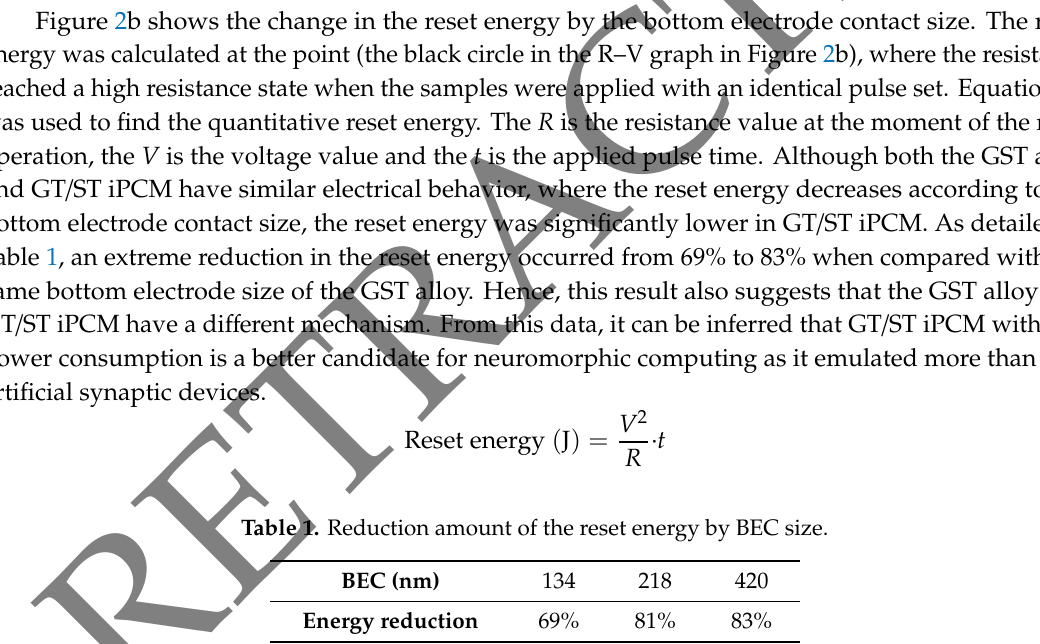
Figure 2. ( a ) A R–V graph of the GT/ST iPCM and Ge–Sb–Te (GST) alloy by the pulse width time, ( b ) a comparison graph of the reset energy by the bottom electrode contact (BEC) size (134, 218, 420 nm) between the GT/ST iPCM and GST alloy. The R–V graph in the figure shows the reset operation for each BEC size.